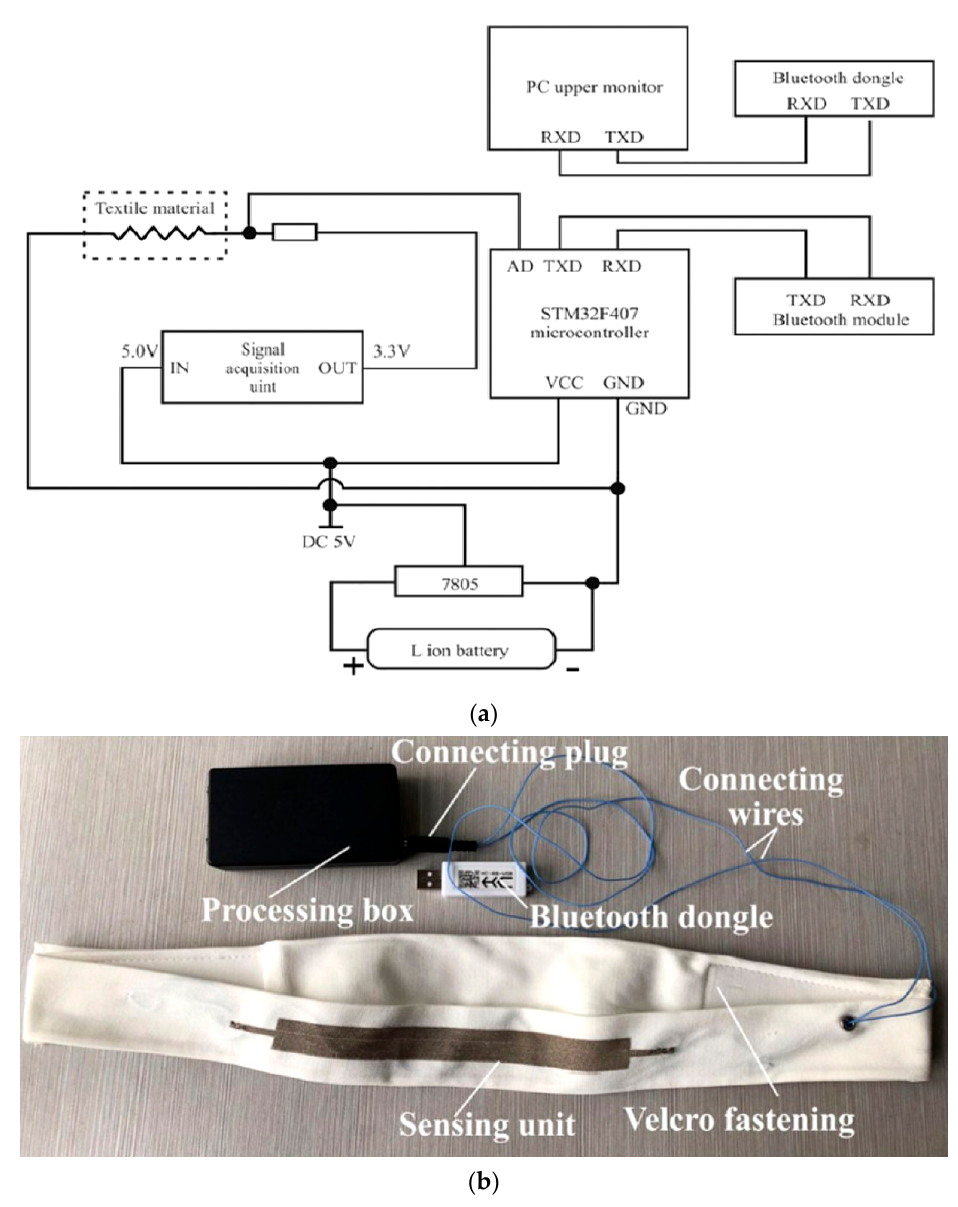
Figure 3. KTC’s circuit diagram scheme ( a ); KTC respiration system prototype ( b ) [53].